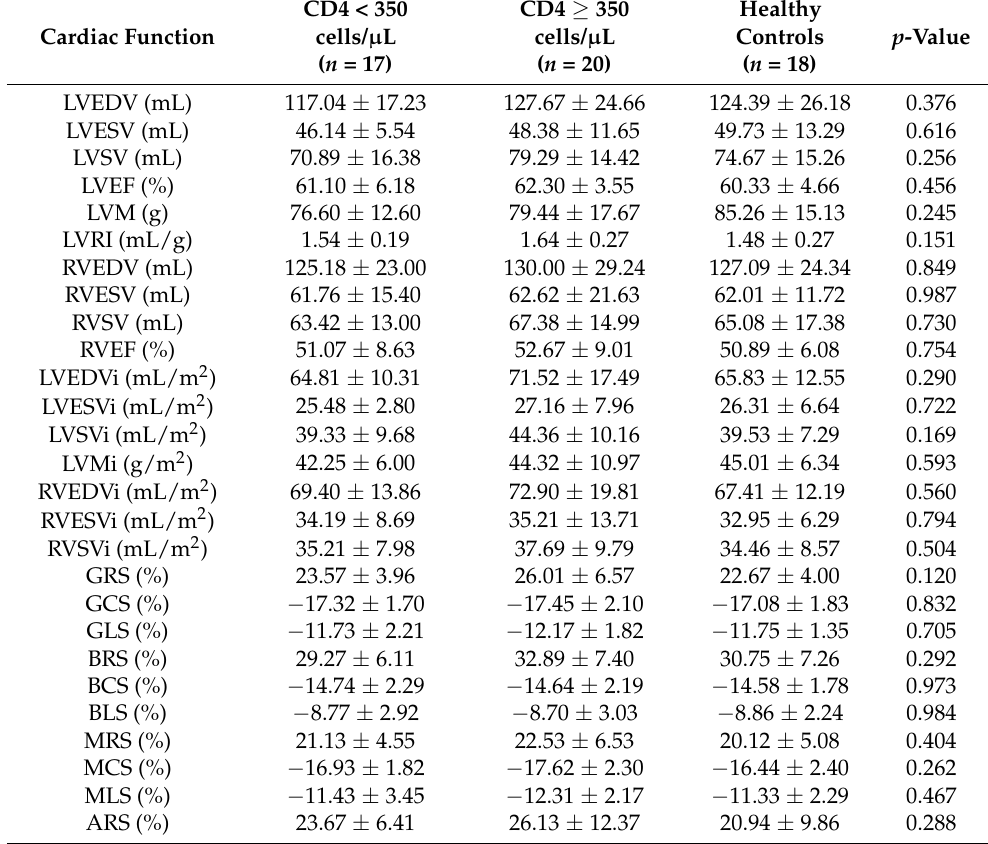
Table 3. Subgroup analysis according to the CD4+ T-cell counts.